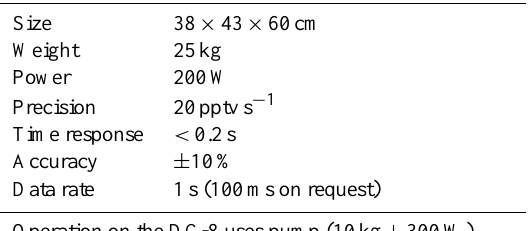
Table 1. Summary of the ISAF instrument